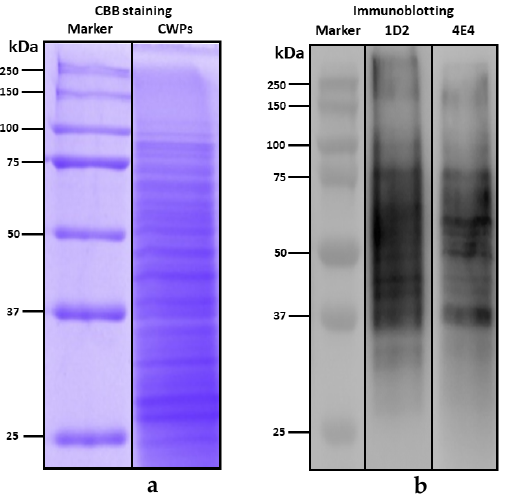
a b Figure 4. Characterization of Aspergillus fumigatus antigens recognized by mAbs 1D2 and 4E4. The A. fumigatus cell wall proteins (CWPs) were separated by SDS-PAGE and stained by Coomassie Brilliant Blue (CBB) ( a ). By Western blotting ( b ), both mAb 1D2 and 4E4 showed a diffuse signal to A. fumigatus CWPs with molecular weight exceeding 37 kDa, particularly some visible bands with molecular weight between 37 kDa and 75 kDa.